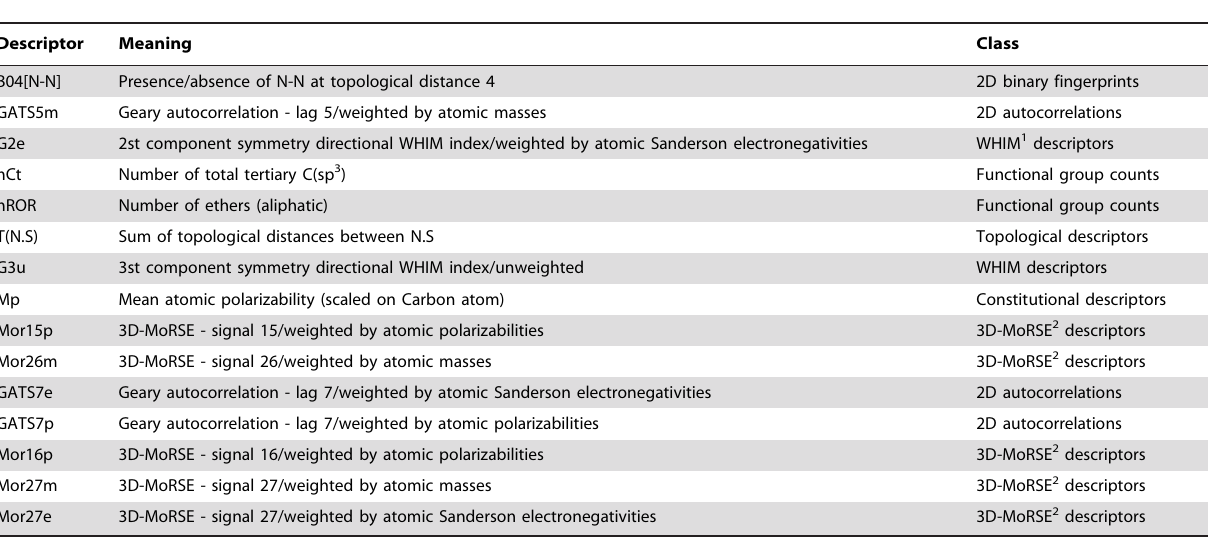
Table 5. Meanings of the robust descriptors influencing significantly the CP-response of